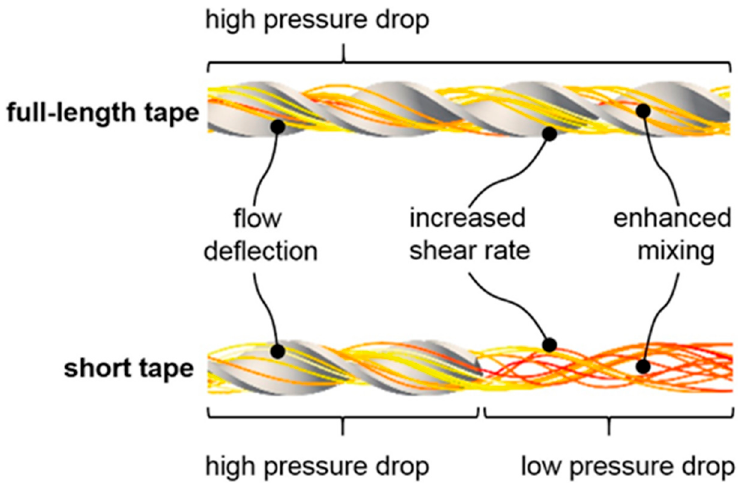
Figure 6. Shortening and spaced twisted tapes in tubular membranes aimed at biofouling mitigation